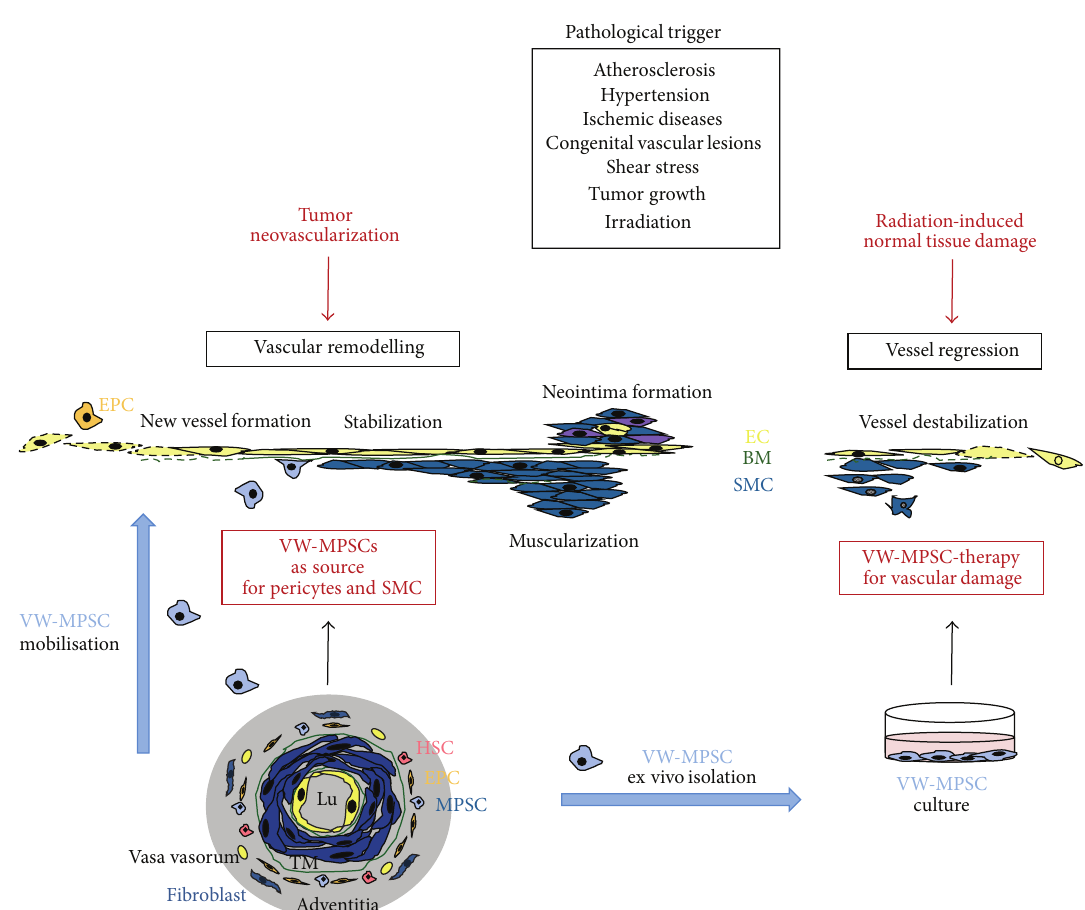
Figure 1: Vascular wall-resident multipotent stem cells of mesenchymal nature within the process of vascular remodeling. Vascular remodeling is a dynamic and strictly regulated process of structural changes, which often occurs as a result of a pathological trigger: atherosclerosis, thrombosis, hypertension, ischemic diseases, congenital vascular lesions, shear stress, irradiation, and tumor growth are crucially characterized by increased vascular remodeling. An ordered remodeling is an absolute prerequisite to preserve the sensitive relationship between resilience and stability of the vessel wall. The association with mural cells (pericytes and smooth muscle cells, SMC) is critical for proper vascular development, stabilization, and maintenance and there is an increasing evidence that these cells originate from multipotentmesenchymalstemcells(MSCs).Intima,media(TM),andadventitiawithvasavasorumarefixedlayersofthewalloflargearteries and veins. The border between media and adventitia is marked by outer elastic membrane (green). The vasculogenic zone is a vascular mural zone located within the adventitia and close to the tunica media which harbors different subsets of vascular wall stem cells. In particular, vascular wall-resident multipotent stem cells of mesenchymal nature (VW-MPSCs) differentiation into SMC may be induced by tumors, inflammation,andhypoxiaintissueareasaroundbloodvesselscontributingtomorphogenesisofnewvesselwalls(e.g.,tumorvascularization, intimal lesions, or neointima formation). It is hypothesized that VW-MPSCs are the “first line” cells which were mobilized from their niche towards the tumor and activated to differentiate into pericytes and SMC, which in turn stabilize angiogenic blood vessels, which results in a stabilization and thus normalization of angiogenic tumor blood vessels. In contrast to the direct action of MPSCs during tumor progression by getting mobilized from their niche and subsequent differentiation at the site of injury, the protective effect of exogenous applied MPSCs could also be related to the modulation of paracrine characteristics of these cells. Besides the relatively simple extraction of these cells for autologous transplantation VW-MPSCs might be perfectly suited for a therapeutic application for improving vascular function or preventing vascular damage because tissue-specific stem cells differentiate mainly to the tissue type, from which they derive. HSP: hematopoietic stem cell; EPC: endothelial progenitor cell; light blue: VW-MPSCs yellow, endothelial cells; green basement membrane and elastic membrane; blue,